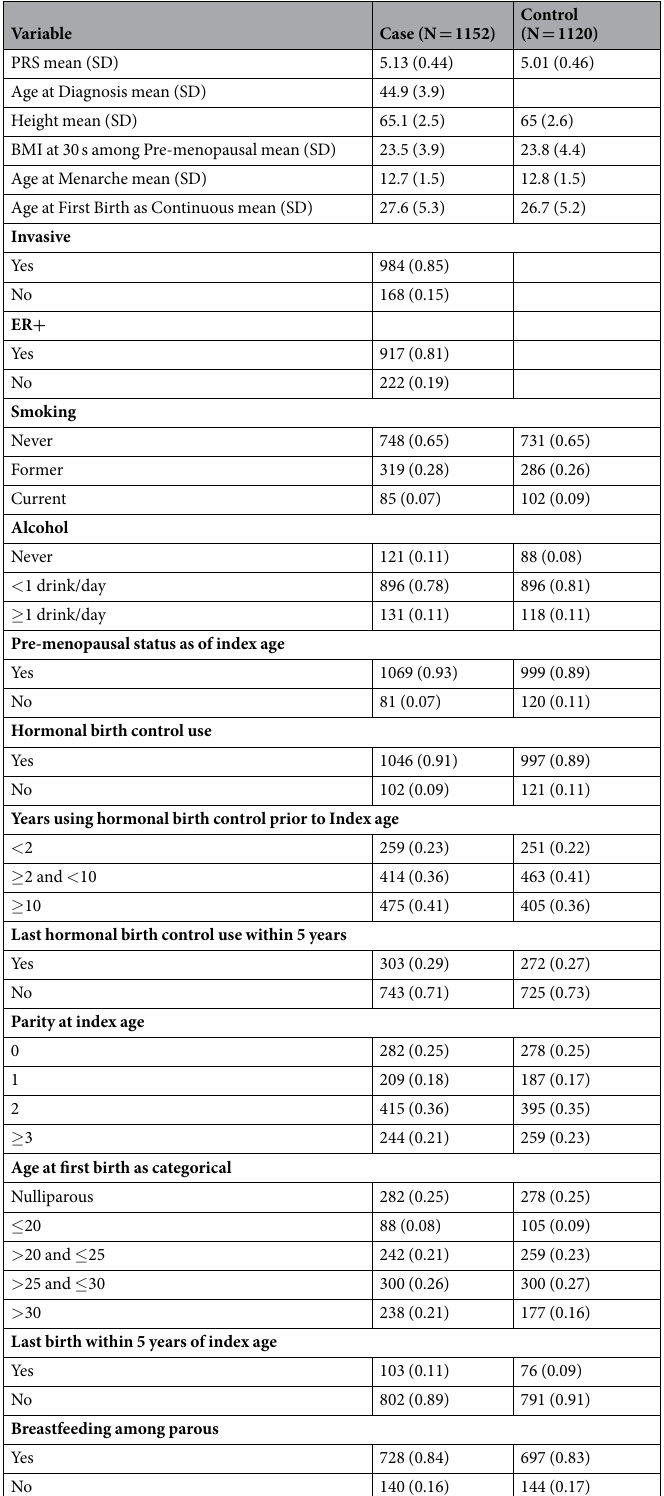
Table 2. Characteristics of the non-Hispanic white participants. Count (proportion) is shown for categorical variables and mean (standard deviation, SD) is shown for continuous